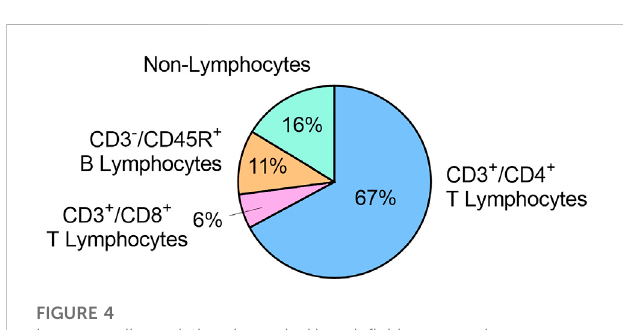
FIGURE 4 Immunecellpopulationsincervicallymph fl uid,expressedasmean % of total viable cells (n =